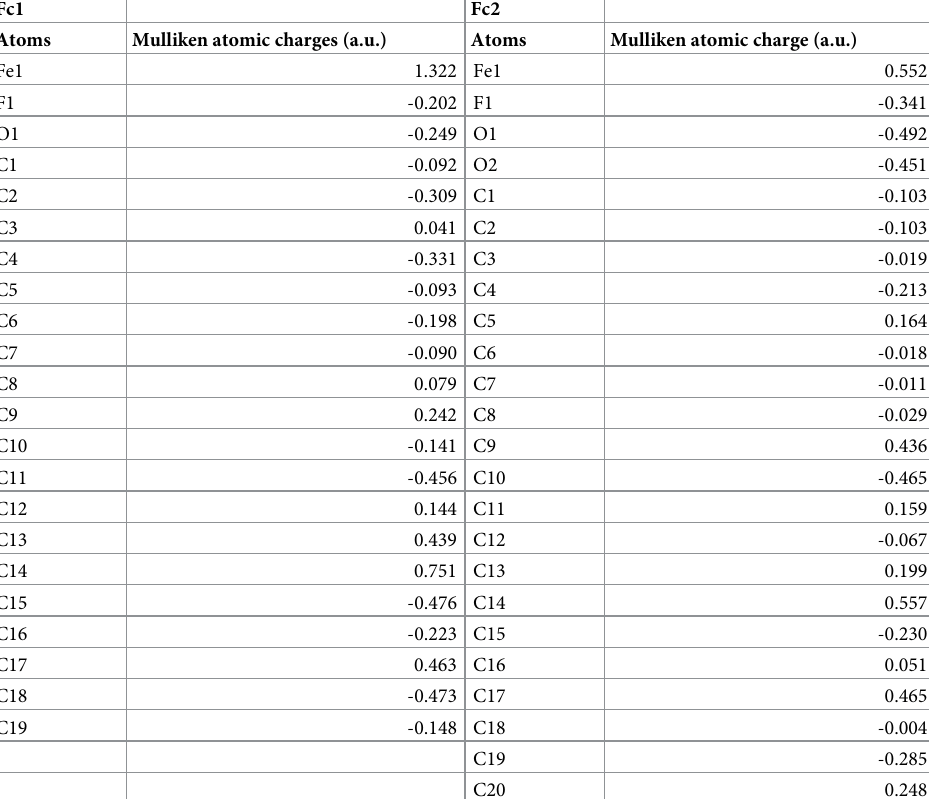
Table 4. Mulliken’s atomic charges of Fc1 and Fc2 performed at B3LYP methods with 6–311++G(d,p). Fc1 Fc2 Atoms Mulliken atomic charges (a.u.)